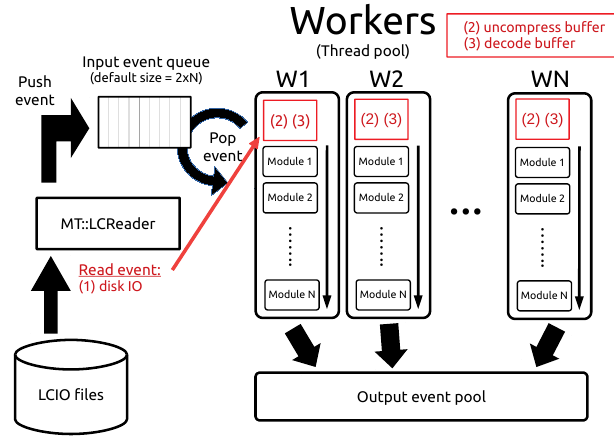
Figure 2. Schematic view of the MarlinMT parallel event processing (PEP) scheduler.